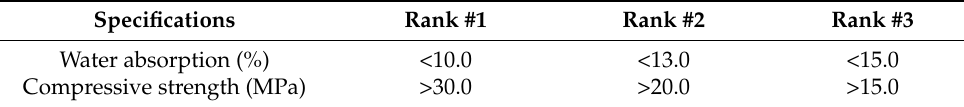
Table 5. CNS common brick specifications.